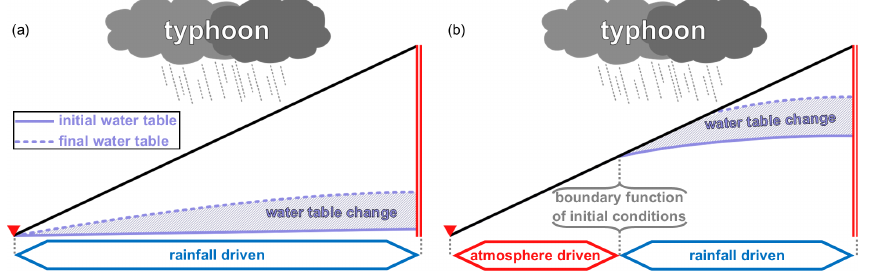
Figure 7. Diagram representing the hillslope and the main driving effect for a potential landslide during a typhoon. If the water table is deep (a) because of a high diffusivity or dry season, the rainfall effects are dominant all along the hillslope. However, if the initial water table reaches the surface (b) because of a low diffusivity or a wet season, any failure near the toe of the hillslope will be driven by atmospheric effects only. The boundary between atmospheric-driven and rainfall-driven domain shifts towards the crest of the hillslope the higher the initial water